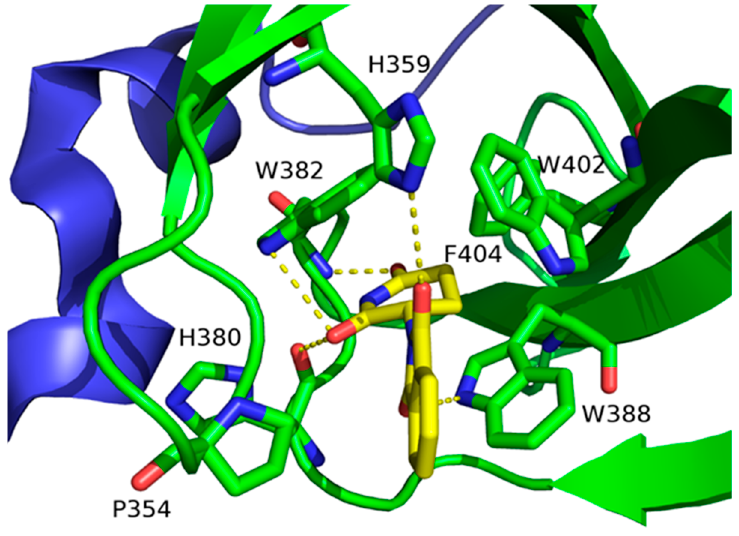
Figure 6. X-ray structure of the complex between thalidomide and CRBN (PDB code: 4CI1). Thalido- mide and CRBN residues interacting are represented as sticks and colored by atom type (N, blue; O, red; C, yellow and green for thalidomide and CRBN, respectively). Other residues are displayed as ribbon and are colored green in the thalidomide binding domain, and blue in the rest of CRBN.